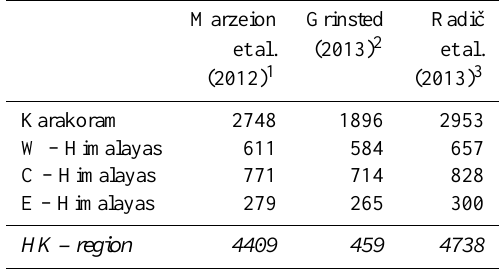
Table 7. Ice-volume estimates (km 3 ) of the HK region according to the V–A approaches from Marzeion et al. (2012), Grinsted (2013), and Radiˇc et al. (2013) applied to the glacier inventory used in this study.